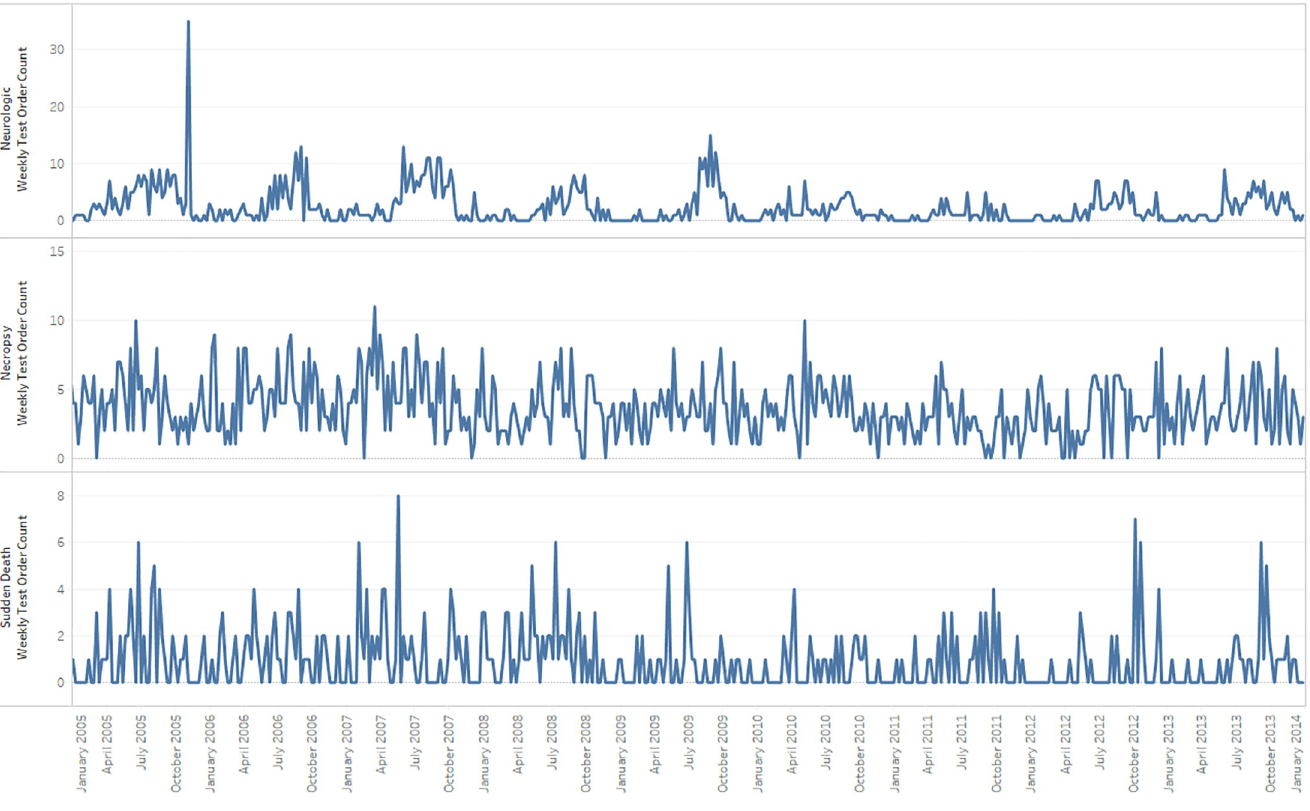
Fig 4. Time series plots of weekly counts of Neurologic, necropsy, and sudden death syndromes.